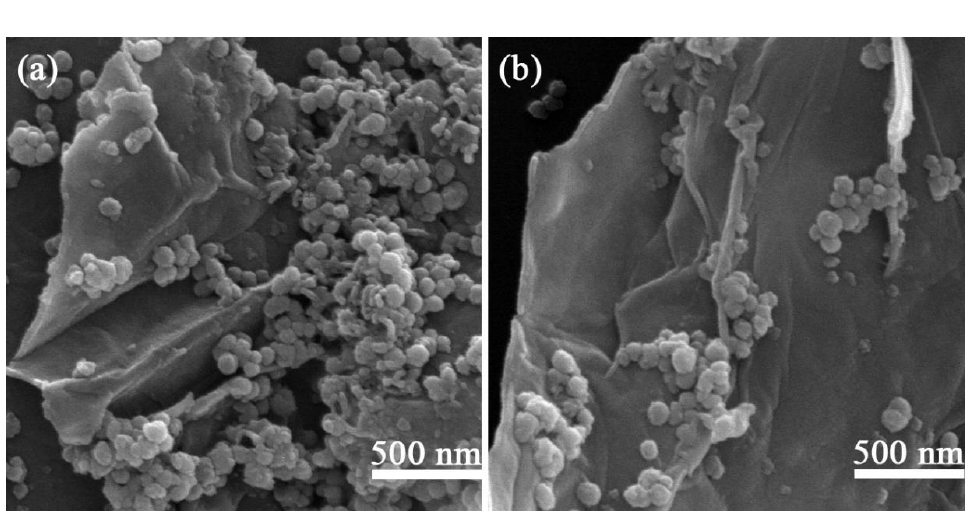
Figure 1. Scanning electron microscope (SEM) image of ( a ) BT@ZnPc-GO-1 and ( b ) BT@ZnPc-GO-2.